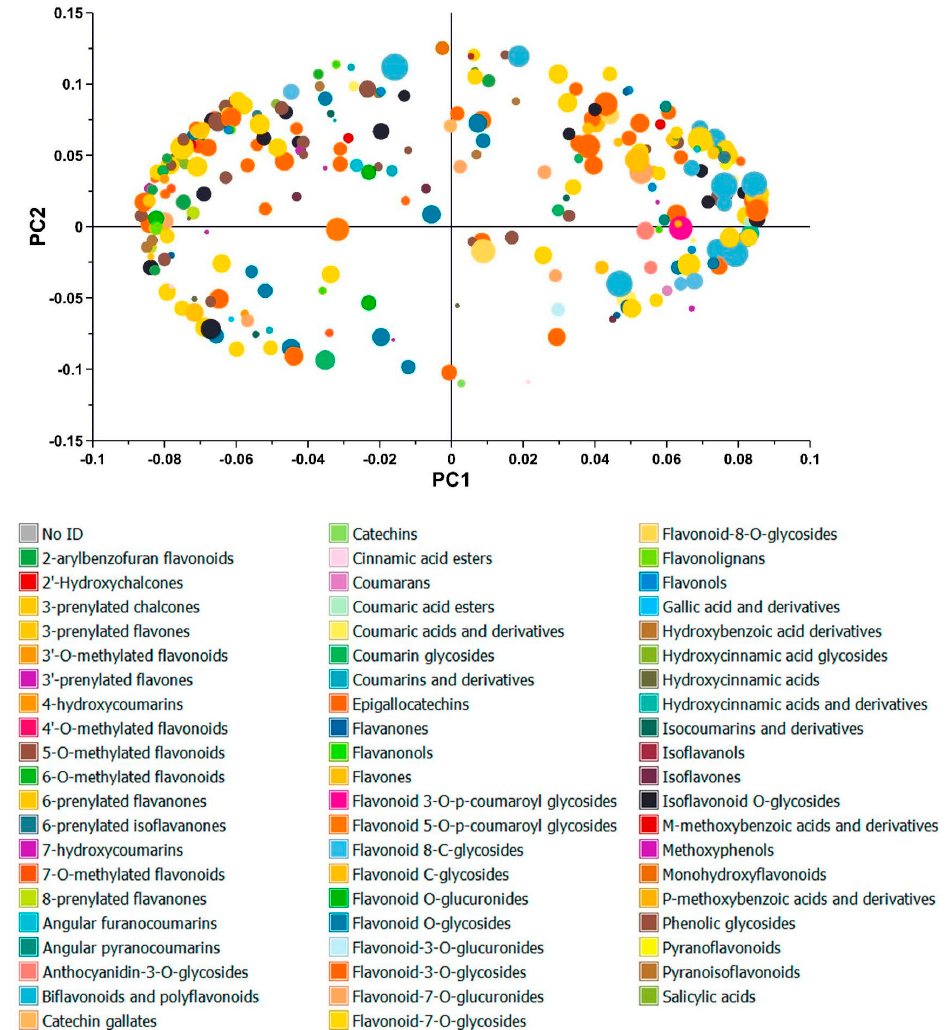
Figure 5. PCA loadings plot of QGP extracts coloured by polyphenol species and size. Polyphenols are coloured by their ontology and scaled by their molecular weight. Major ontologies include flavonoids, flavones, chalcones, isoflavones, flavanones, flavanonols, flavonols, isoflavanols, catechins, coumarins, hydroxybenzoic acids, hydroxycinnamic acids, and various flavonoid glycoside configurations which are attached at different locations on the flavonoid skeleton structure (e.g., Flavonoid-3- O -glycosides and Flavonoid-7- O -glycosides). The smallest and largest phenolic compounds were 138 m/z (Salicylic acid) and 898 m/z [Gallocatechin(4alpha->8)]2catechin respectively.